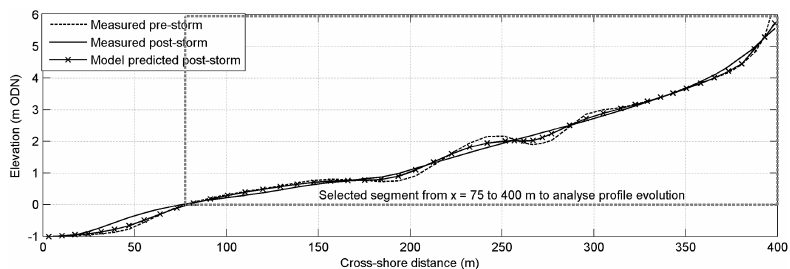
Figure 4. Comparison of measured and modelled profile evolution across transect P14 (13.65–14.00km in Fig. 3) using the optimised calibration factors (facSk and facAs).